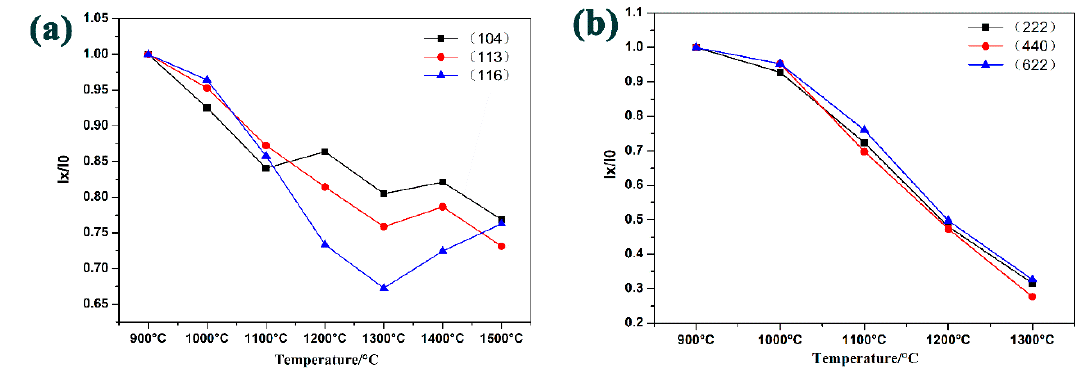
ff raction intensity at di ff erent temperatures to 900 ◦ C: ( a ) α -Al Figure 3. The ratio of diffraction intensity at different temperatures to 900 °C: ( a ) α -Al 2 O 3 ( b ) c-Y 2 O 3 . Figure 3. The ratio of di